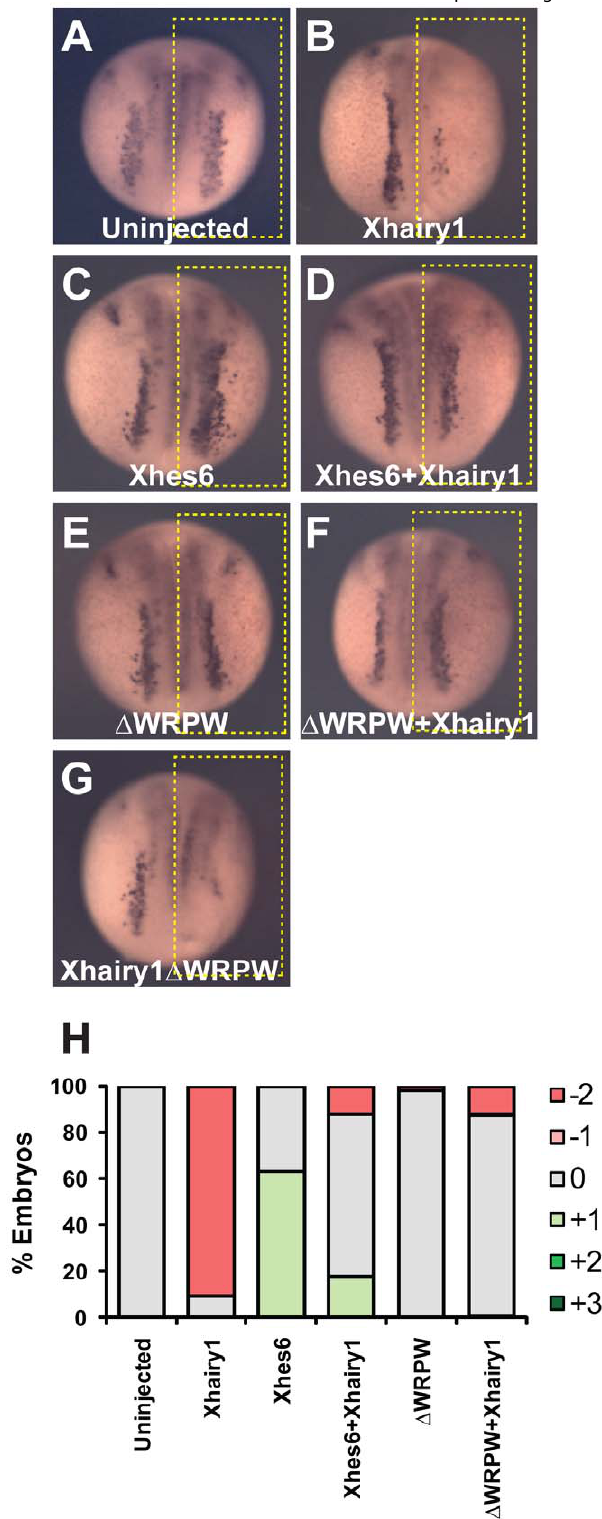
Figure 7. Inhibition of Xhairy1 by Xhes6 does not require the Xhes6 Groucho binding domain. Expression of N-tubulin transcript in uninjected embryos (A) or embryos in which mRNA encoding Xhairy1 (B), Xhes6 (C), Xhairy1 plus Xhes6 (D), Xhes6 D WRPW mutant (E), Xhairy1 plus Xhes6 D WRPW (F) or Xhairy1 D WRPW mutant (G) was injected into one cell at the two cell stage. H: quantitation of changes in N-tubulin mRNA expression, scored as shown in Figure S2. Full data on the frequency of phenotypes and the number of embryos analyzed is given in Table 6.